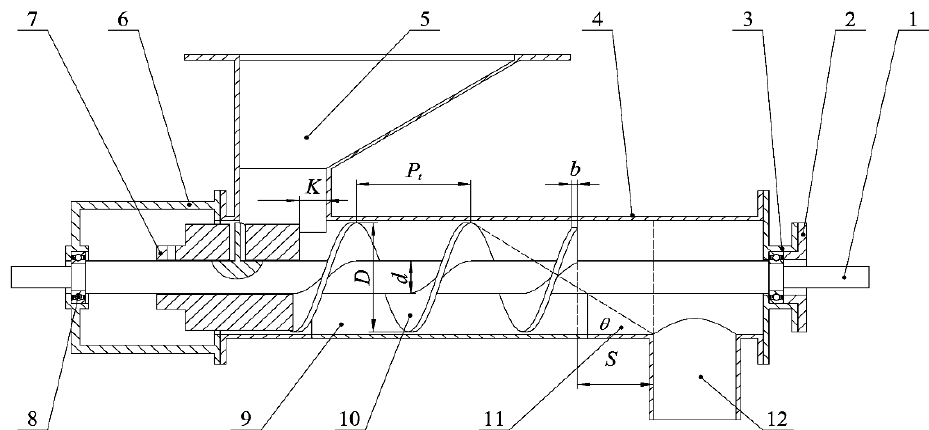
Figure 1. Structure of blocking wheel-type screw fertilizer distributor. 1. Screw shaft 2. Bearing cover 3. End cover of sleeve 4. Sleeve of screw 5. Pyramidal feeding inlet 6. Bearing seat 7. Spiral blocking wheel 8. Bearing 9. Fertilizer cleaning outlet and its cover 10. Screw blade 11. Fertilizer buffering zone 12. Fertilizer outlet. Note: D is the outer diameter of the screw blade, mm; d is the inner diameter of the screw blade, mm; P t is the pitch, mm; b is the average thickness of the screw blade, mm; K is the spiral blocking wheel opening width, mm; S is the outlet distance,